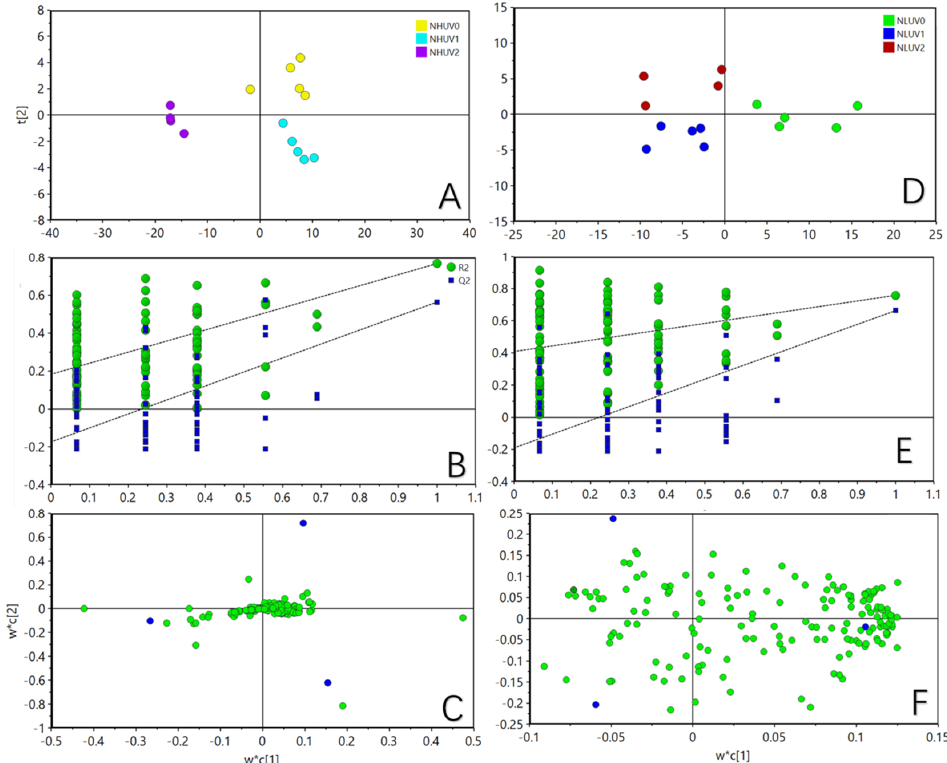
Figure 3. Scores plot ( A , D ), permutation tests ( B , E ), loadings plot ( C , F ) of high ( A , B , C ) or low ( D , E , F ) nitrogen treatment of partial least-squares discriminant analysis (PLS-DA) of lipid content in tea leaves. The blue dots in the loadings plot ( C , F ) represented the substance that contributed most to each treatment. Each green dot represents a substance.